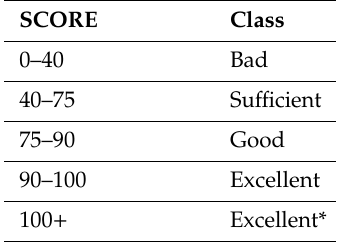
Table 4. Subdivision of building visual quality index (BVQI) in